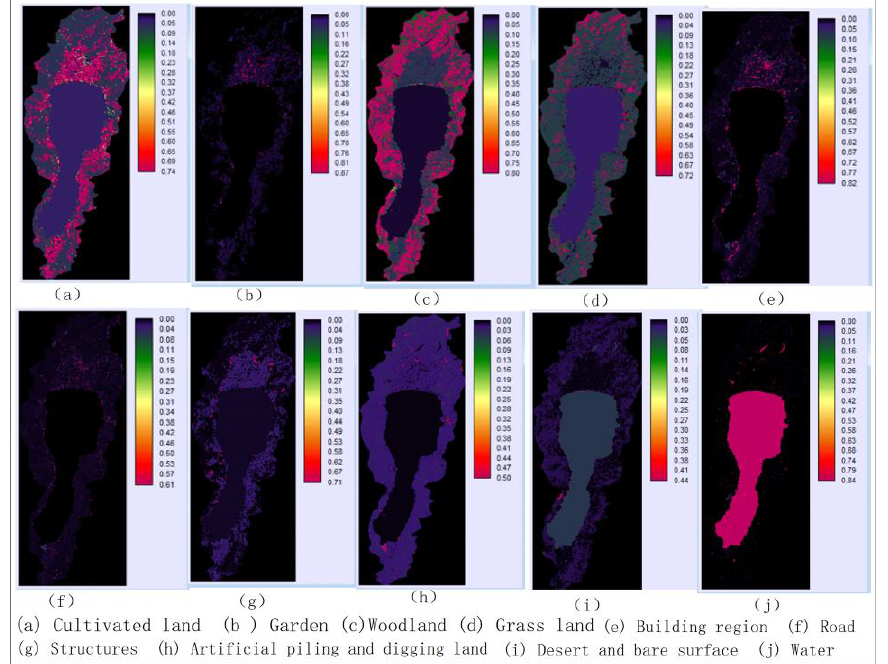
Figure 4. Suitability map used to predict future LUCC